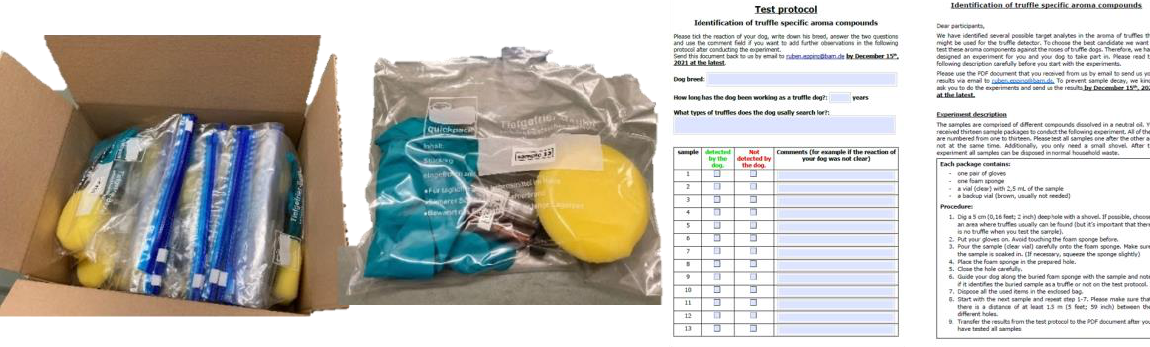
Figure 6. Sample package for the truffle dog experiment.